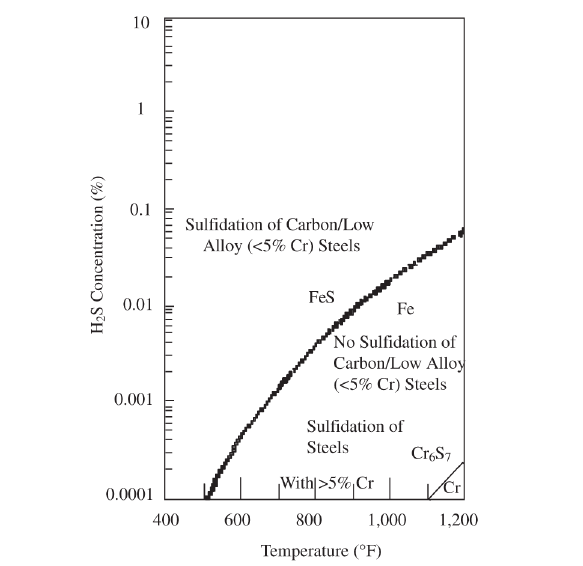
S Partial Pressure Upon the Sulfidation Cor- 2 S Gases at a total Pressure of One Atma 2